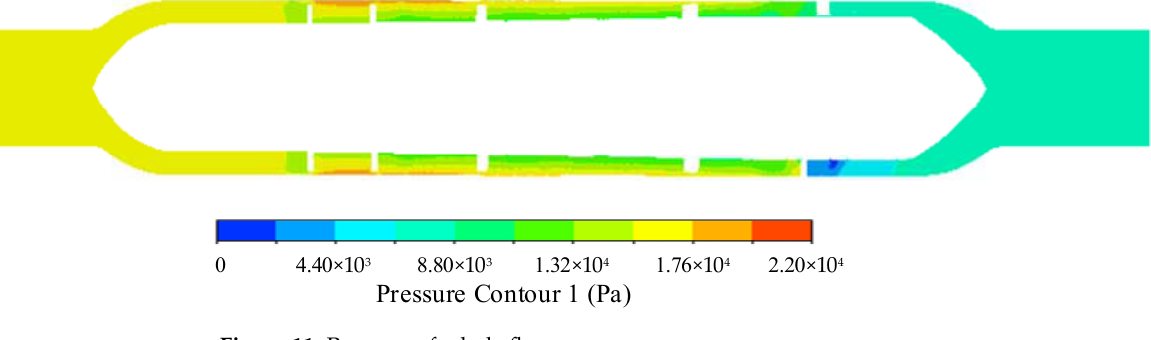
Figure 11. Pressure of whole flow area.